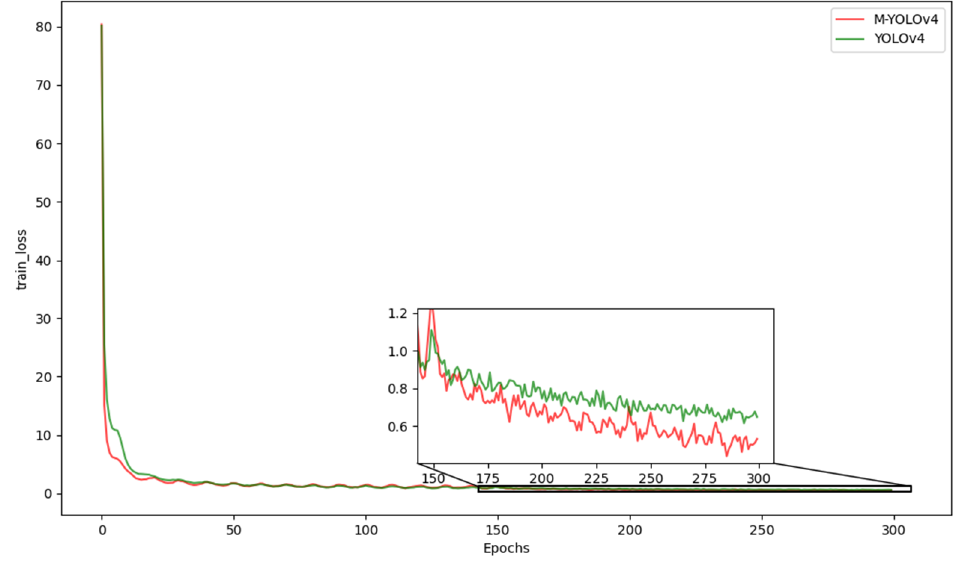
Figure 4. Comparison of loss curves.